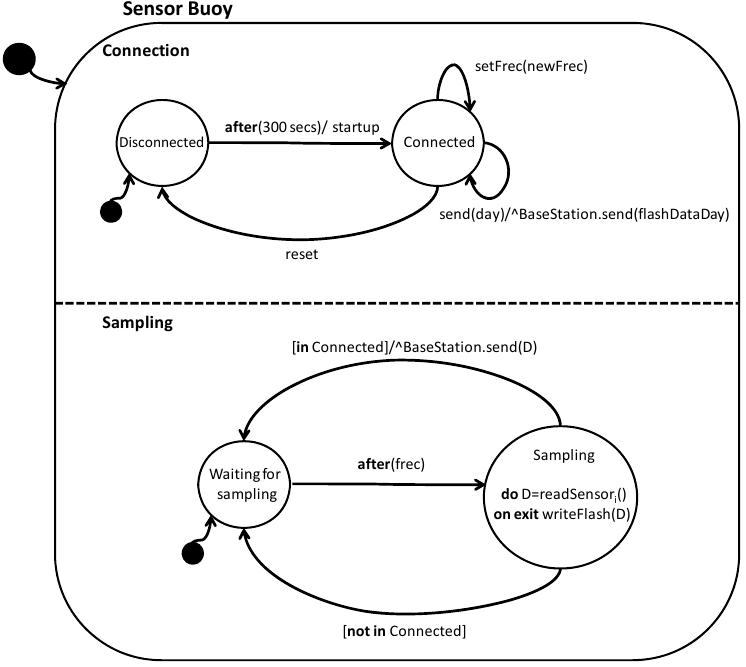
Figure 4. Sensor buoy function state